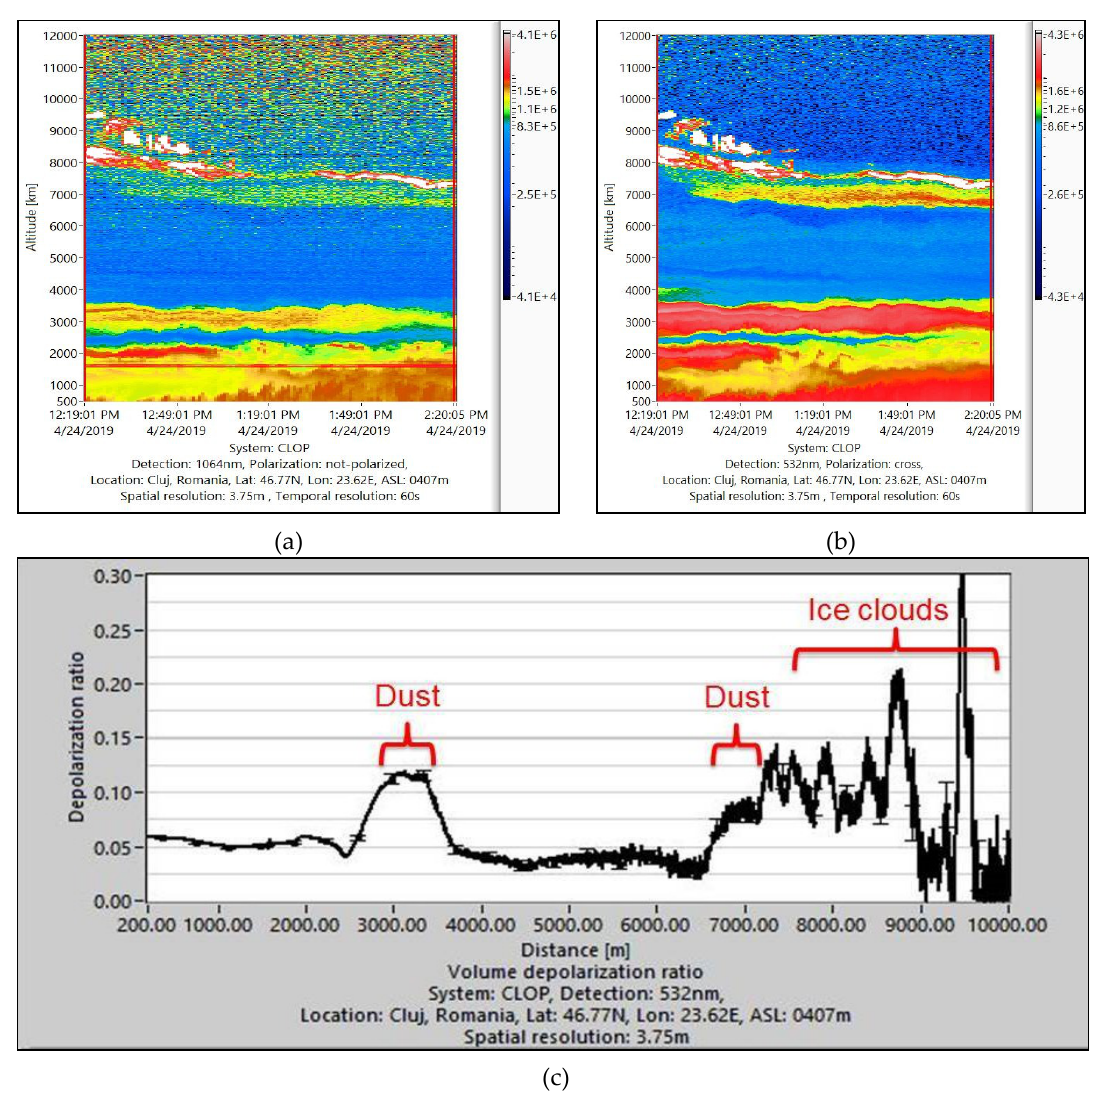
Figure 3. CLOP lidar RCS for 24.04.2019: 12:20–14:20 UTC, Cluj‐Napoca, 407 m ASL, at 1064 nm ( a ) and 532 nm cross ( b ); volume depolarization ratio at 532 nm( c )